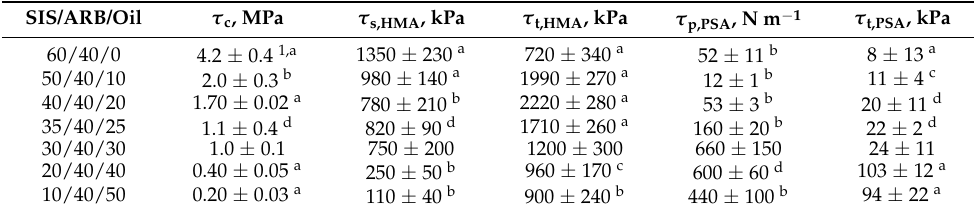
Table 3. Strength and adhesion characteristics of the mixtures with different ratios between styrene- isoprene-styrene triblock copolymer (SIS) and naphthenic oil and the same concentration of asphal- tene/resin blend